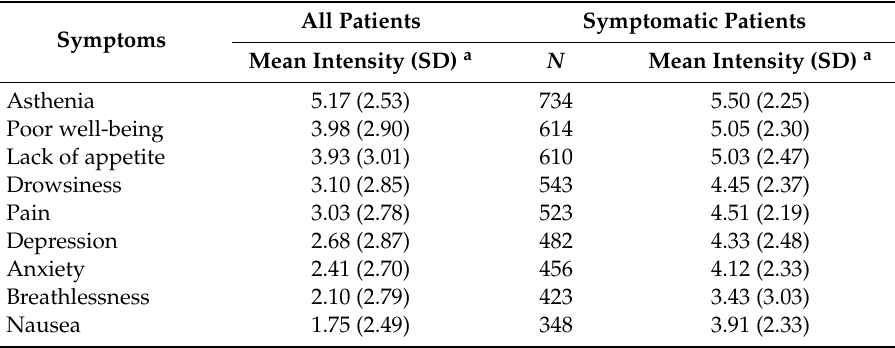
Table 3. Intensity of the most frequent symptoms in 780 patients at baseline.